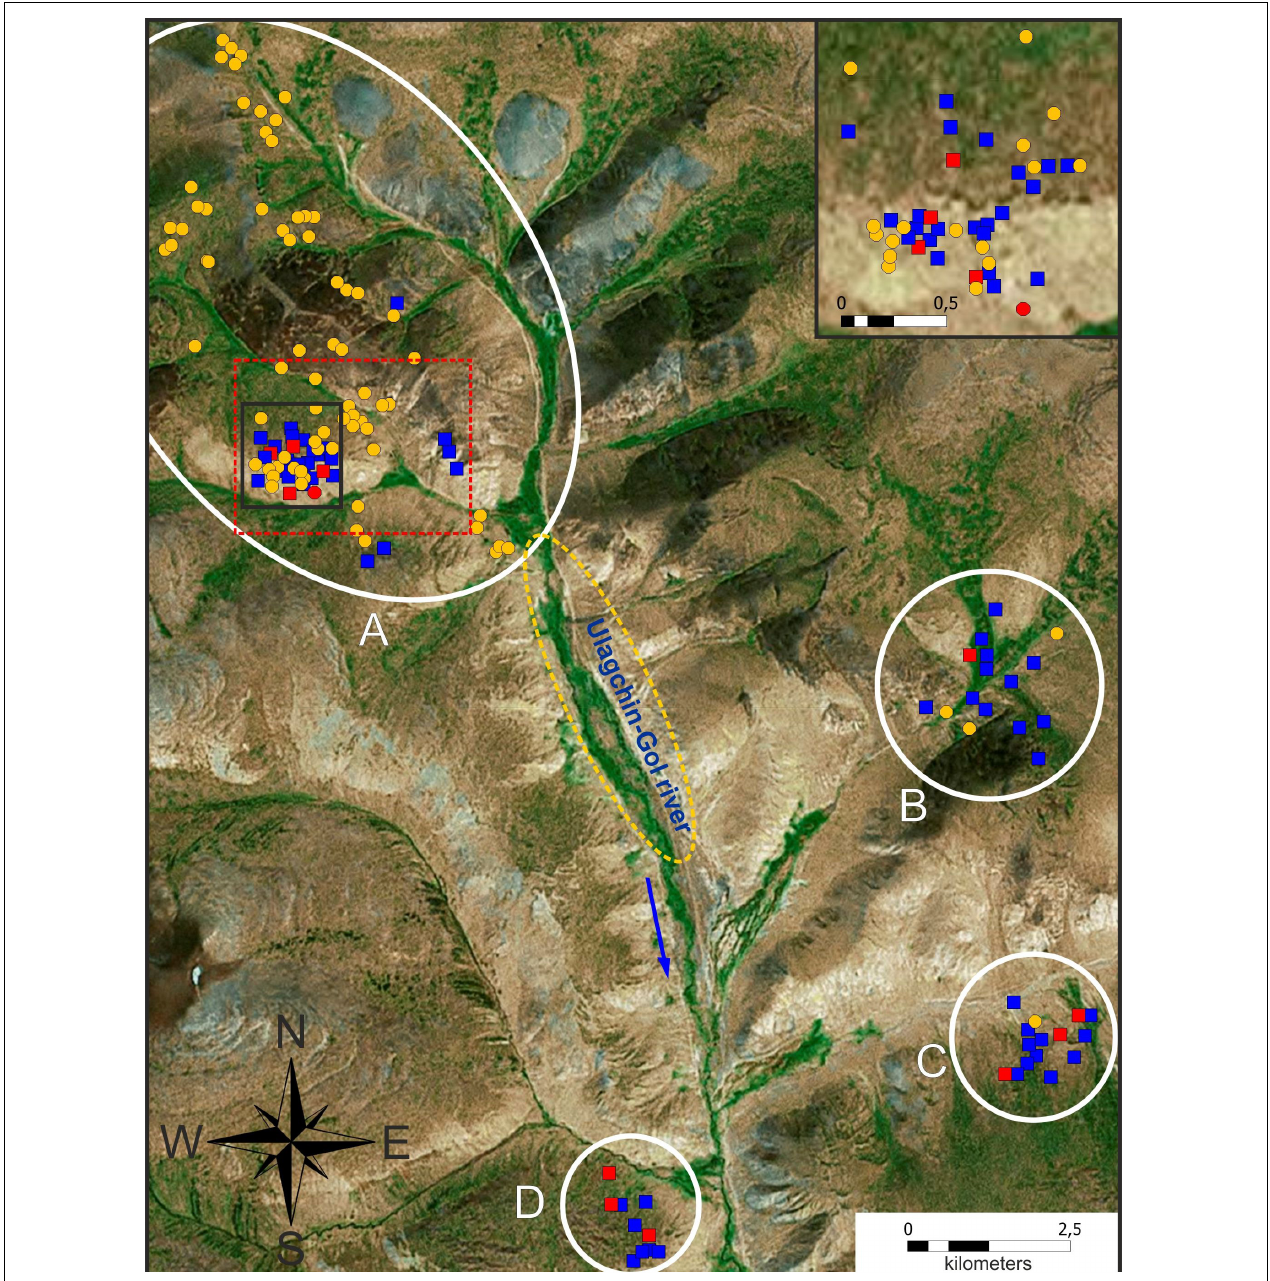
FIGURE 3 | Distribution of two marmot species in the Ulagchin-Gol valley based on analysis of acoustic signals. Blue squares indicate marmots with baibacina alarm calls, yellow circles indicate sibirica , red icons indicate individuals with aberrations of alarm calls (squares— baibacina , circle– sibirica ). (A–D) —plots of surveying. The yellow dotted line indicates the area of the valley where the sound signals were identified as sibirica by the researcher by ear (explanation in the text). The blue arrow indicates the direction of the Ulagchin-Gol river flow. The red dotted frame indicates the area where marmots were genotyped (see Figure 4 ).